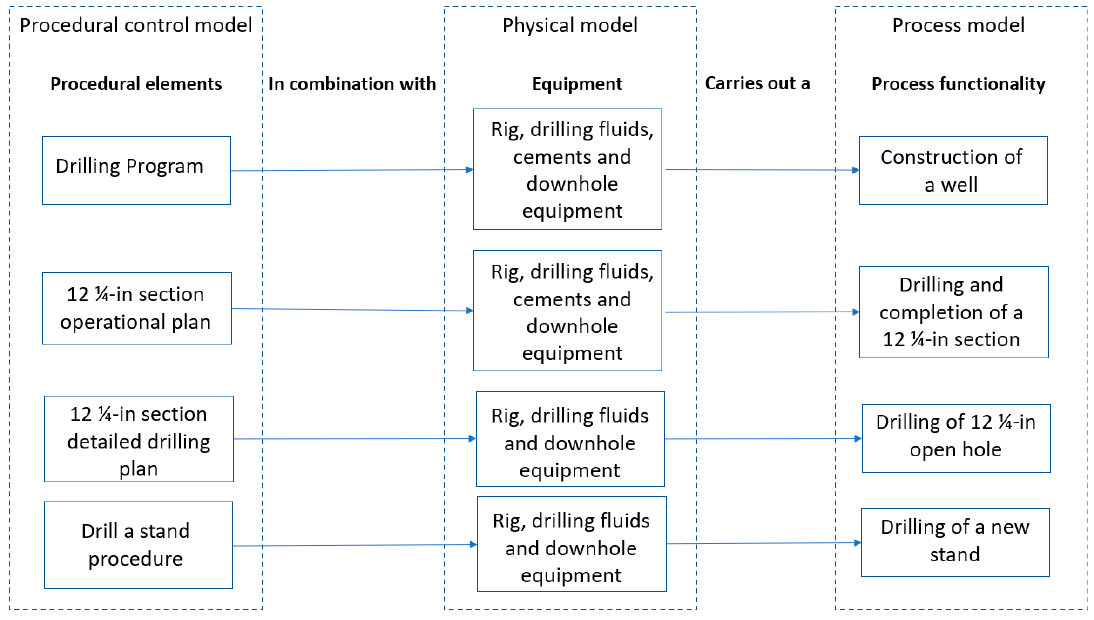
Figure 5. ISA-88 representation of a drilling operation.